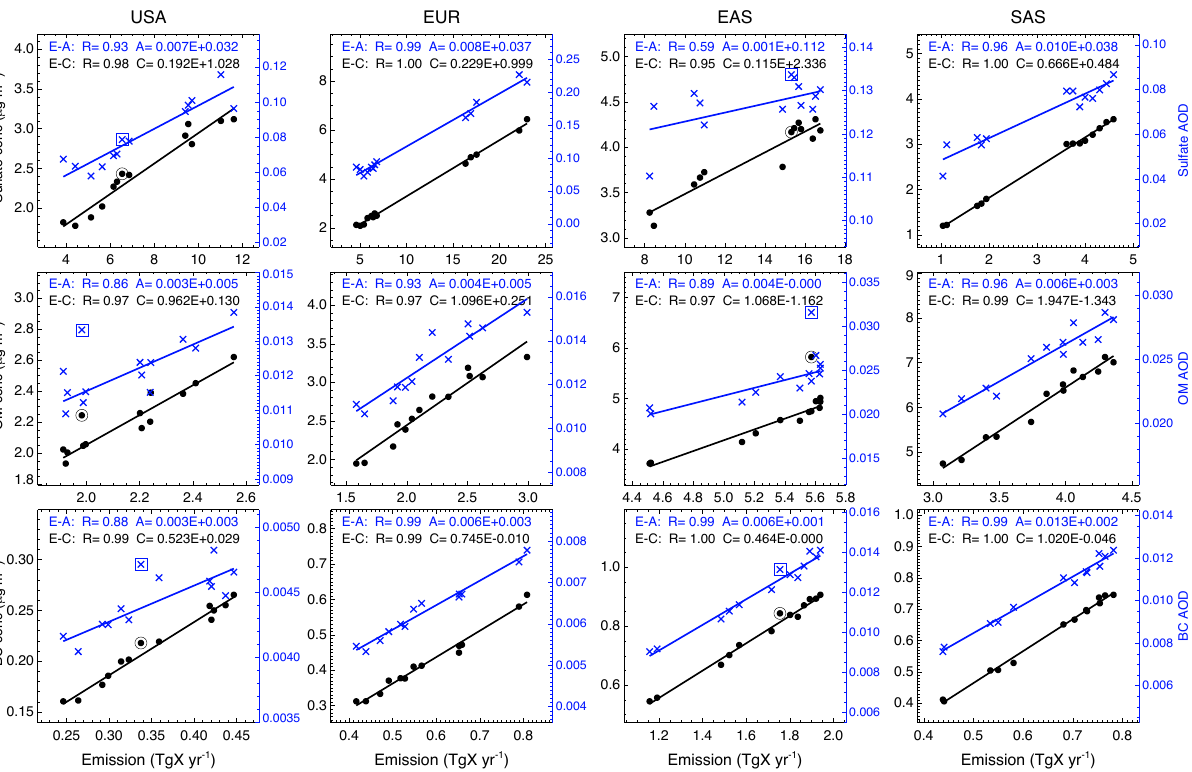
Fig. 12. Model-estimated relationship between emission (E) and surface concentrations (C) (black dots) or AOD (A) (blue crosses) of sulfur (total sulfur emissions, mainly SO 2 , and sulfate concentration or AOD) (1st row), OM (2nd row), and BC (3rd row) on regional and annual average over USA (1st column), Europe (2nd column), East Asia (3rd column), and South Asia (4th column) in years without global- (highlighted with large open circles for surface concentrations and open squares for AOD) because of the significant influence from the transport of the Russian wild fires (see text). Emissions are expressed as annual total within the individual regions in TgXyear − 1 , where X is S for sulfur and C for BC and